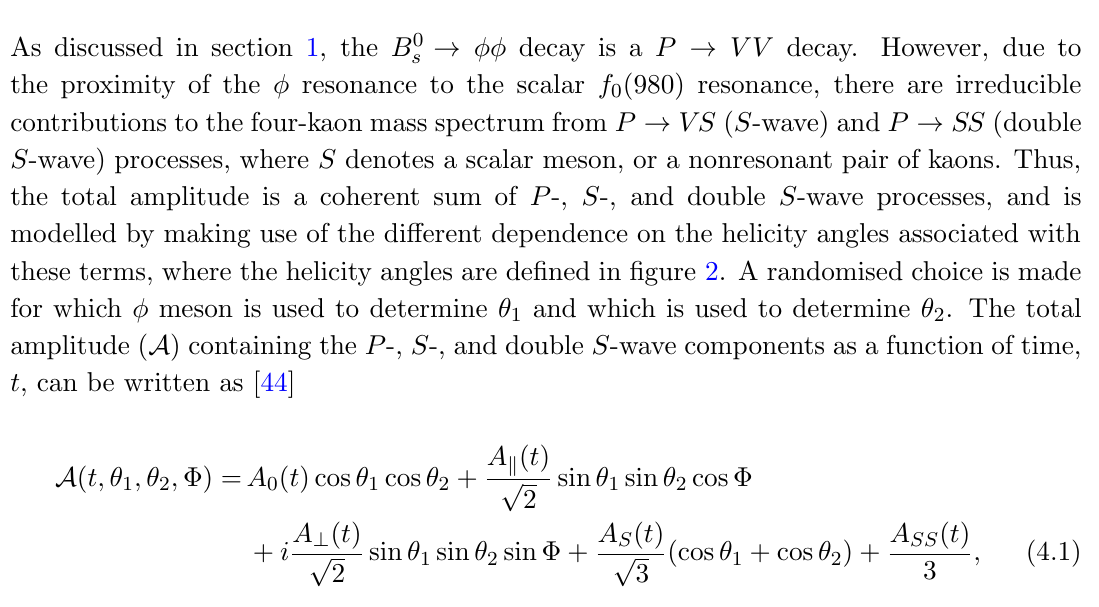
! (cid:30)(cid:30) decay, where (cid:18) 1 ; 2 is the angle between the K + momentum s rest frame, (cid:8) is the angle between the s is the unit vector normal to the decay plane of the (cid:30) 1 ; 2 1 ; 2